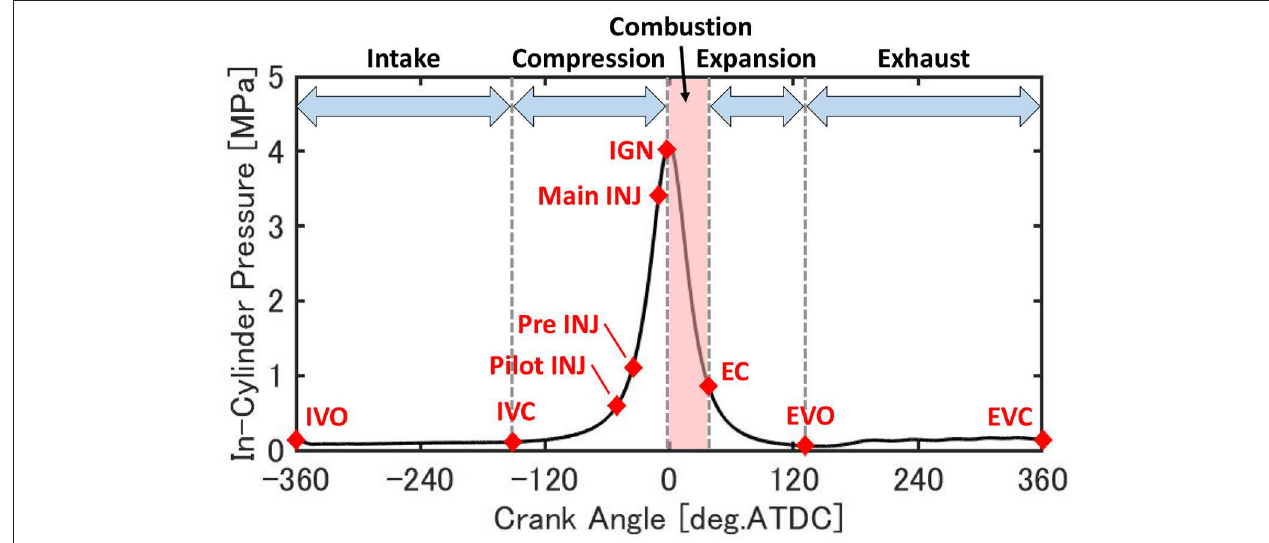
FIGURE 3 | The discrete points and processes in the